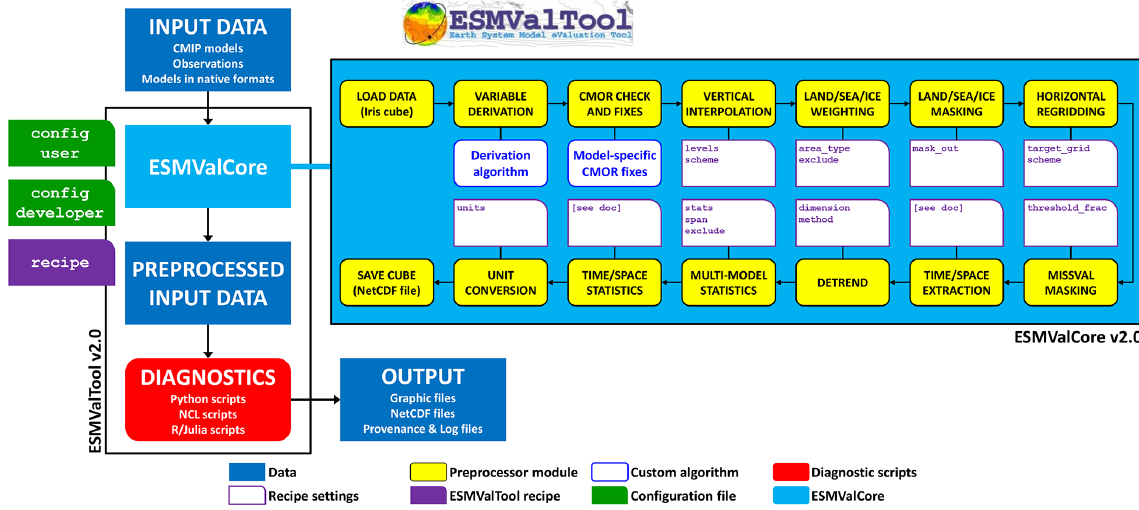
Figure 1. Schematic representation of ESMValTool